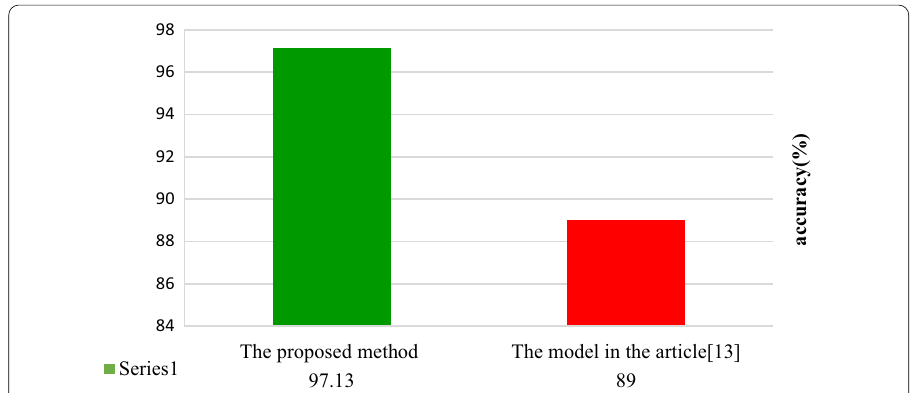
Fig. 7 Comparison of classification accuracy and diagnosis accuracy of the proposed model with those of